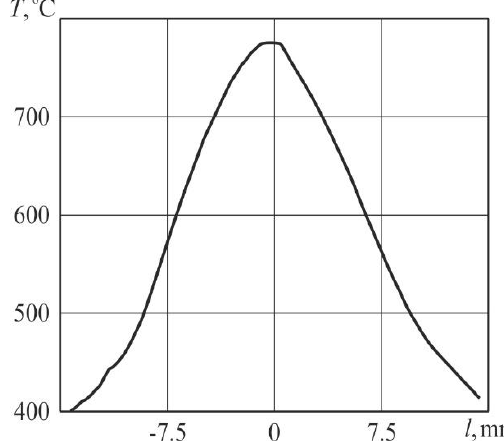
Figure 5. Distribution of temperature along the sample.